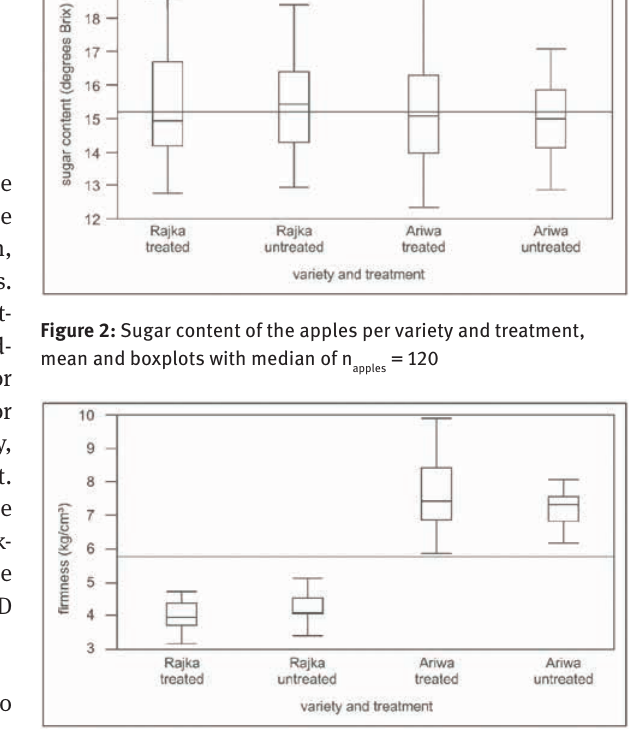
Figure 3: Firmness of the apples per variety and treatment, mean and boxplots with median of n